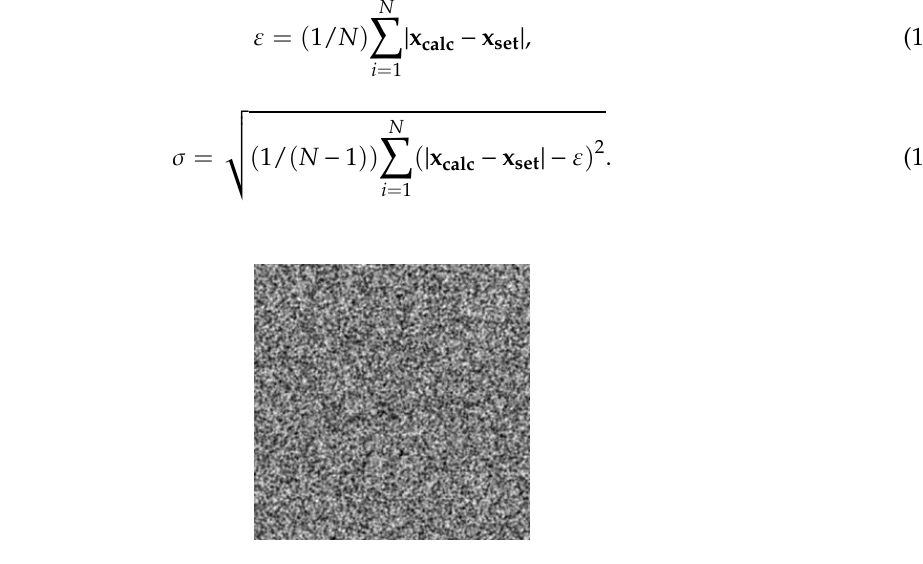
Figure 6. Speckle image generated by a computer.